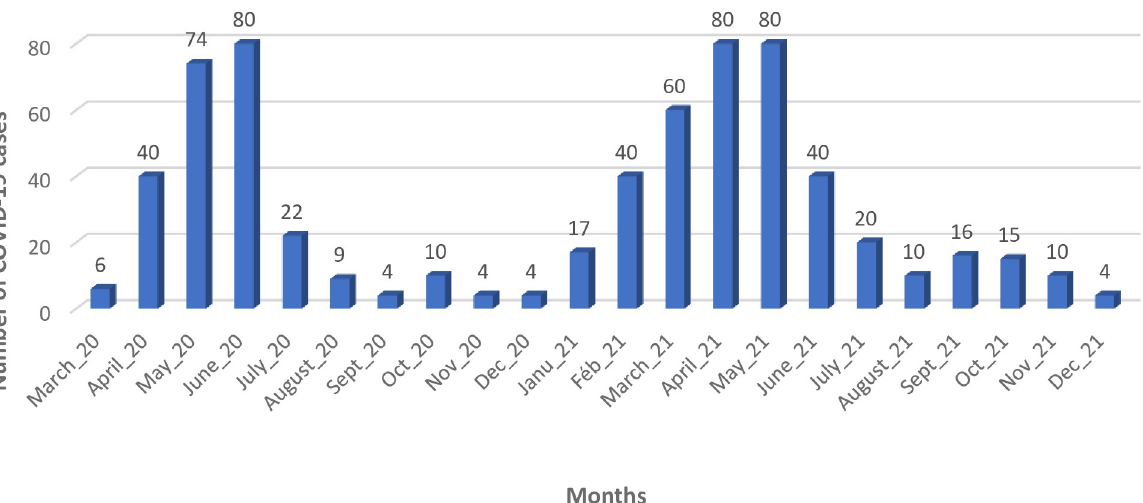
https://doi.org/10.1371/journal.pgph.0001572.t001